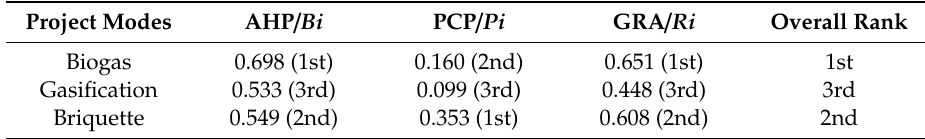
Table 4. Evaluation results and sequencing